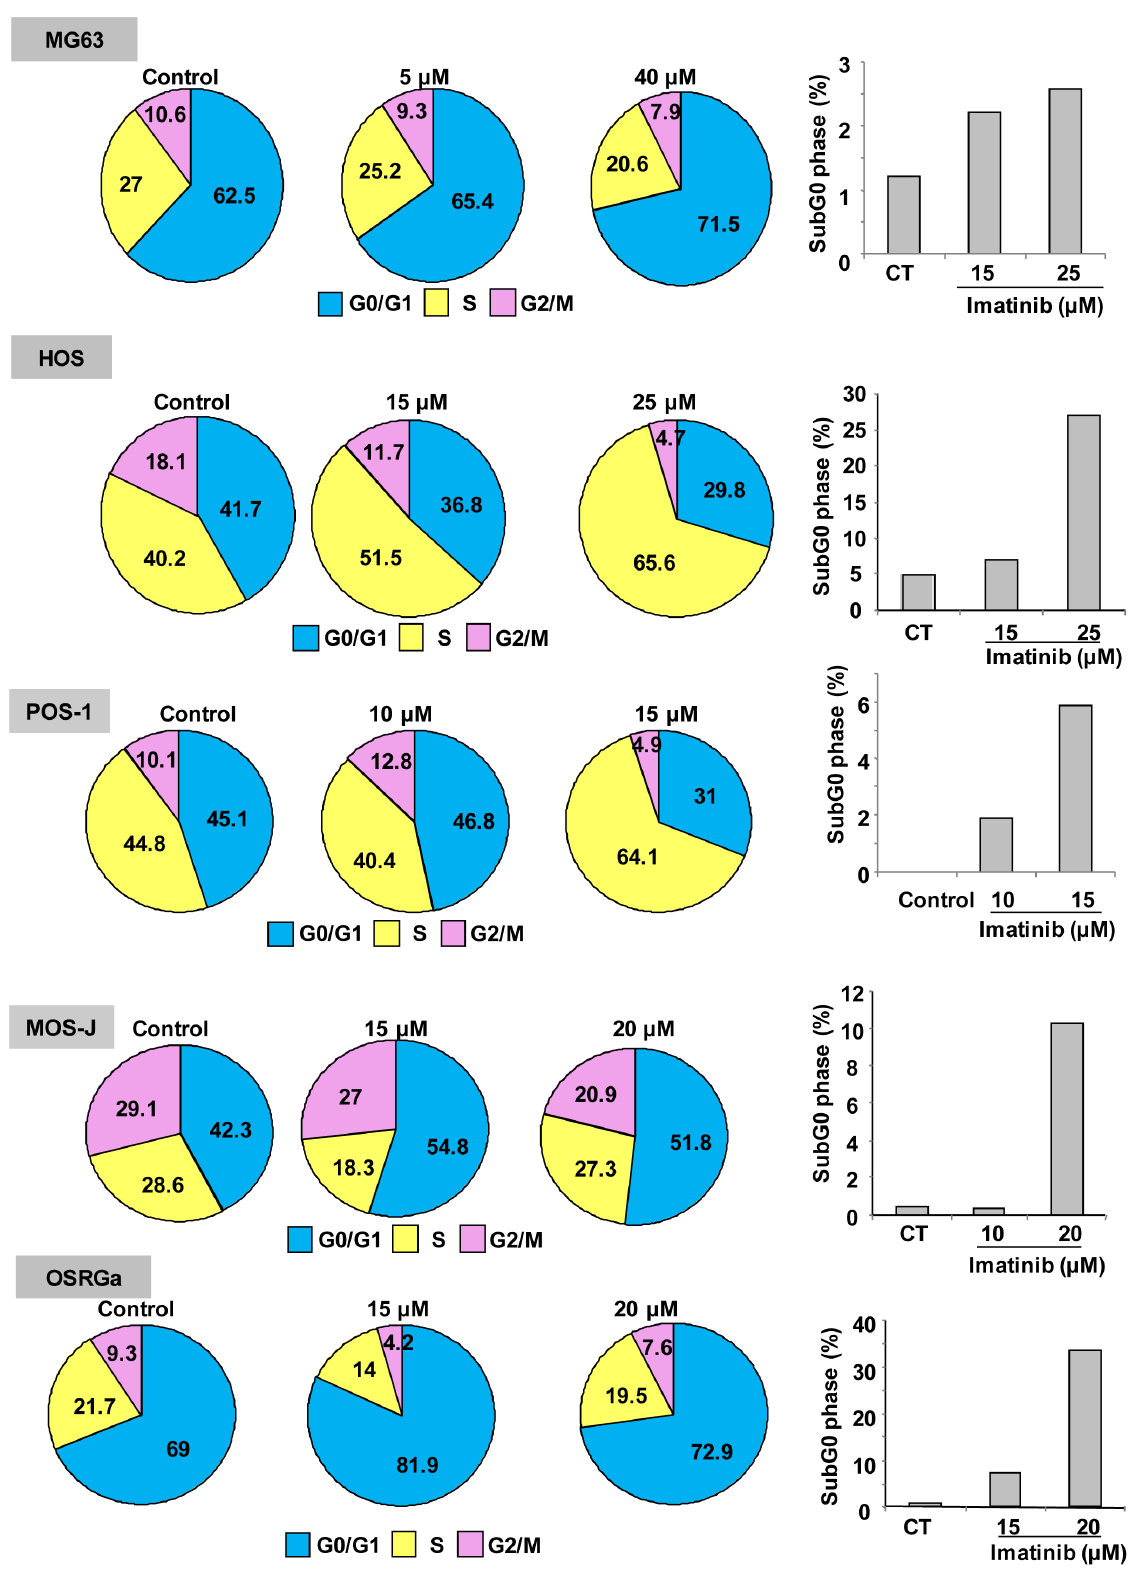
Figure 3. Imatinib mesylate affects osteosarcoma cell proliferation by inducing a cell cycle arrest. Cell cycle distribution of human, mouse and rat osteosarcoma cell lines treated or not with imatinib mesylated for 48 hours was analyzed by propidium iodide staining and flow cytometry. All experiments were repeated 3 times, and representative results are shown.